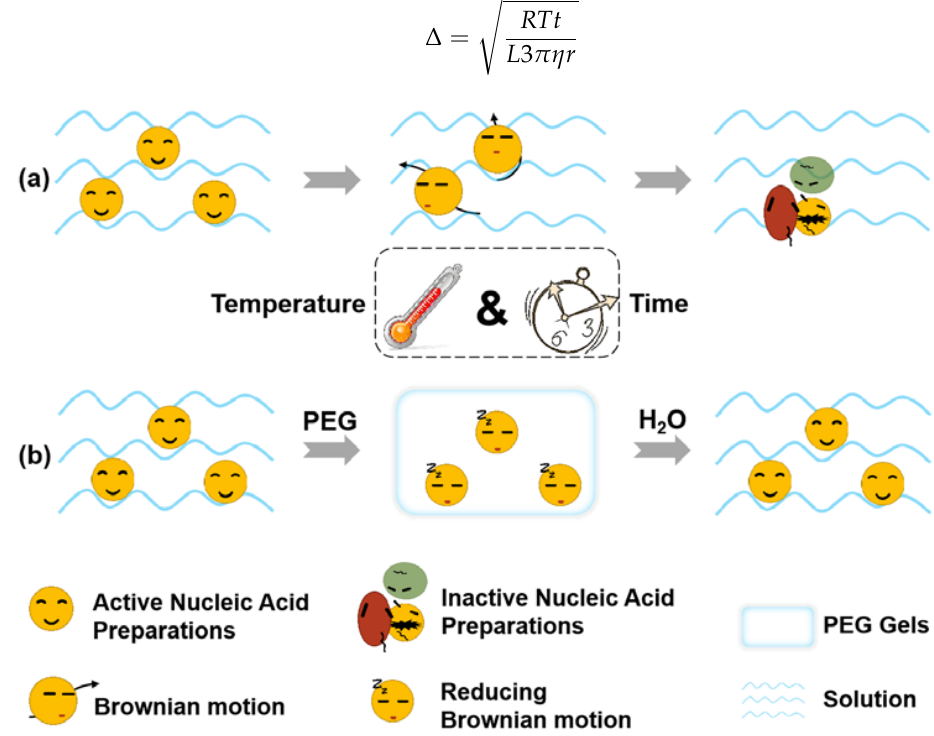
Figure 1. Scheme of improving the storage stability of nucleic acid preparations by PEG gelation. ( a ) Formation of aggregates by the collision of nucleic acid preparations in solution through Brow- nian motion with activity loss. ( b ) When the nucleic acid preparations are wrapped by PEG, the displacement of the nucleic acid particles is decreased and the stability is increased. After adding the aqueous solvent, the active state of the nucleic acid preparations is restored.